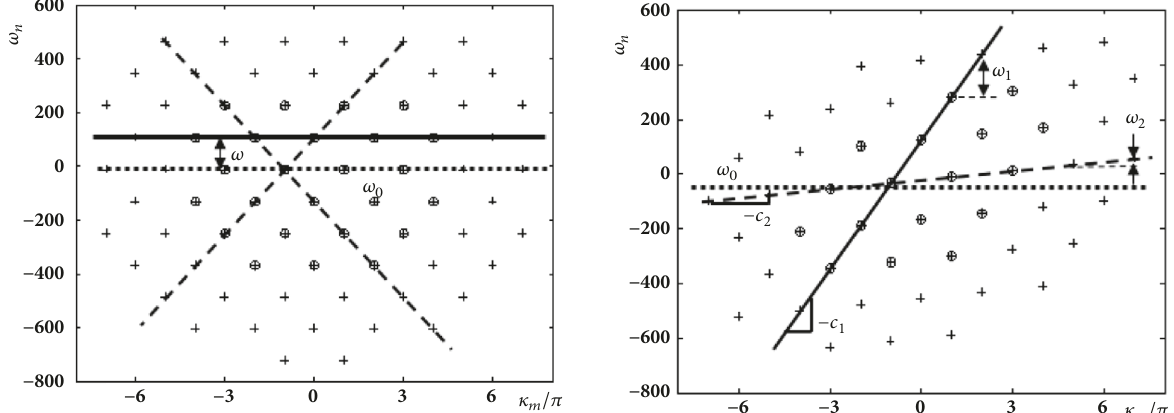
Figure 14: 𝜔 - 𝜅 diagrams resulting from the STKD method applied to the CGLE for the cases considered in Figure 3 (left plot) and Figure 4 (right plot). As in Figure 3, left, and Figure 4, left, crosses and circles label results obtained with high and low accuracies, respectively.